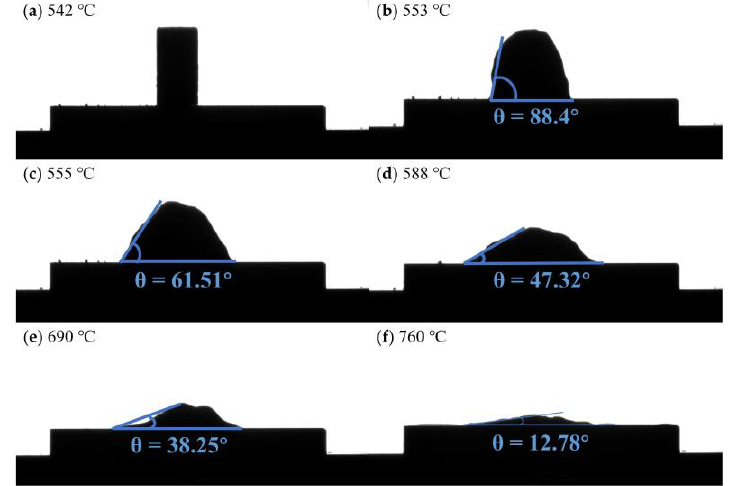
Figure 6. Images of the contact angle between flux #10 and alumina plate at different temperatures: ( a ) 542 °C; ( b ) 553 °C; ( c ) 555 °C; ( d ) 588 °C; ( e ) 690 °C; ( f ) 760 °C.